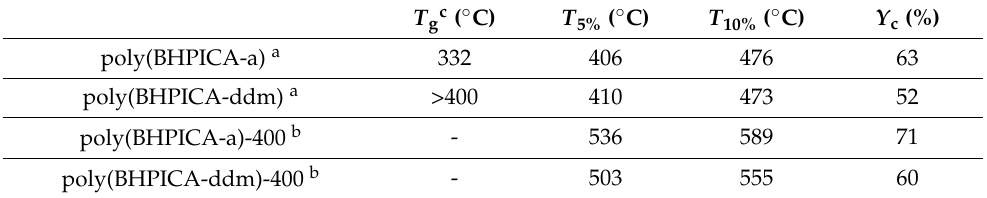
Table 3. Thermal characterization of o -(amide-co-imide) functional polybenzoxazines